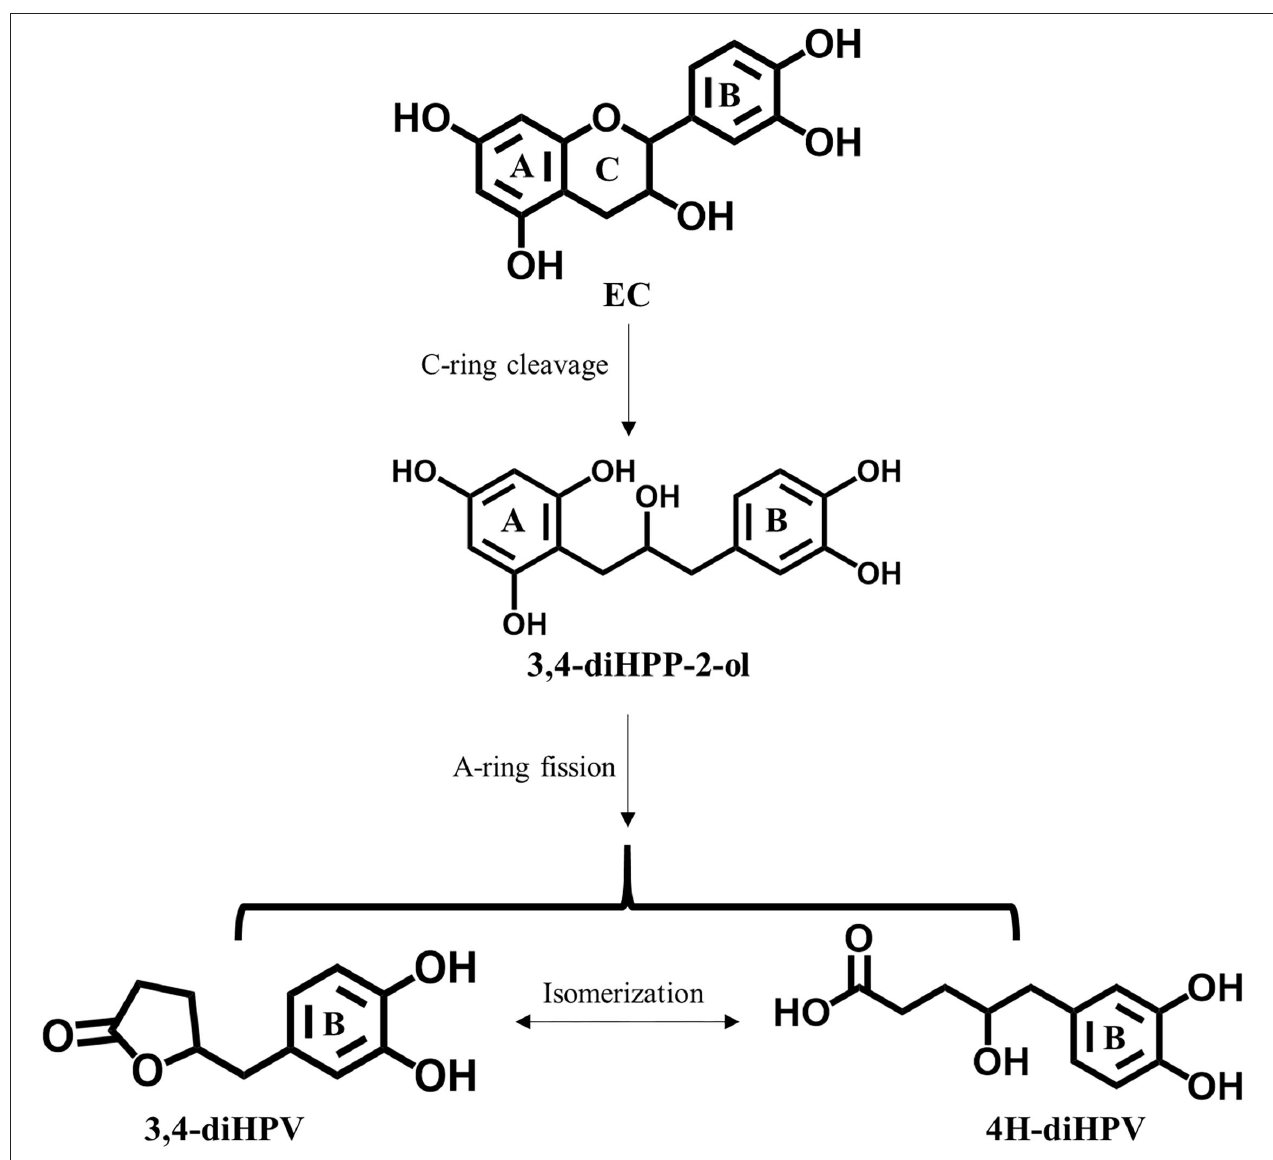
FIGURE 1 | Pathways of human colonic microbial metabolism of Epicatechin